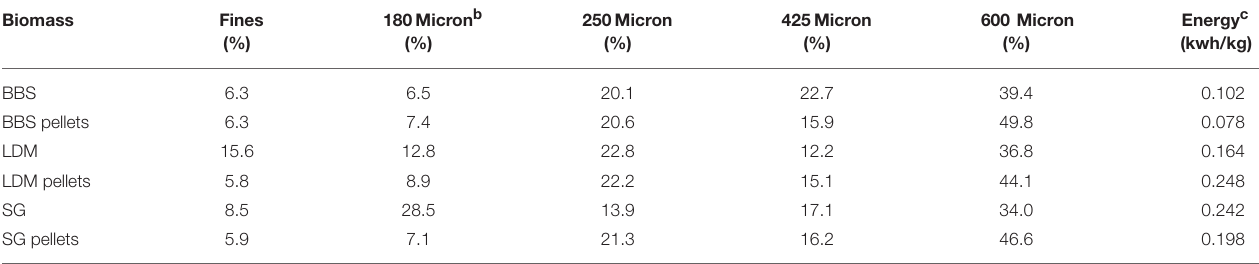
TABLE 3 | Particle reduction using a hammer mill equipped with a 2mm screen a .